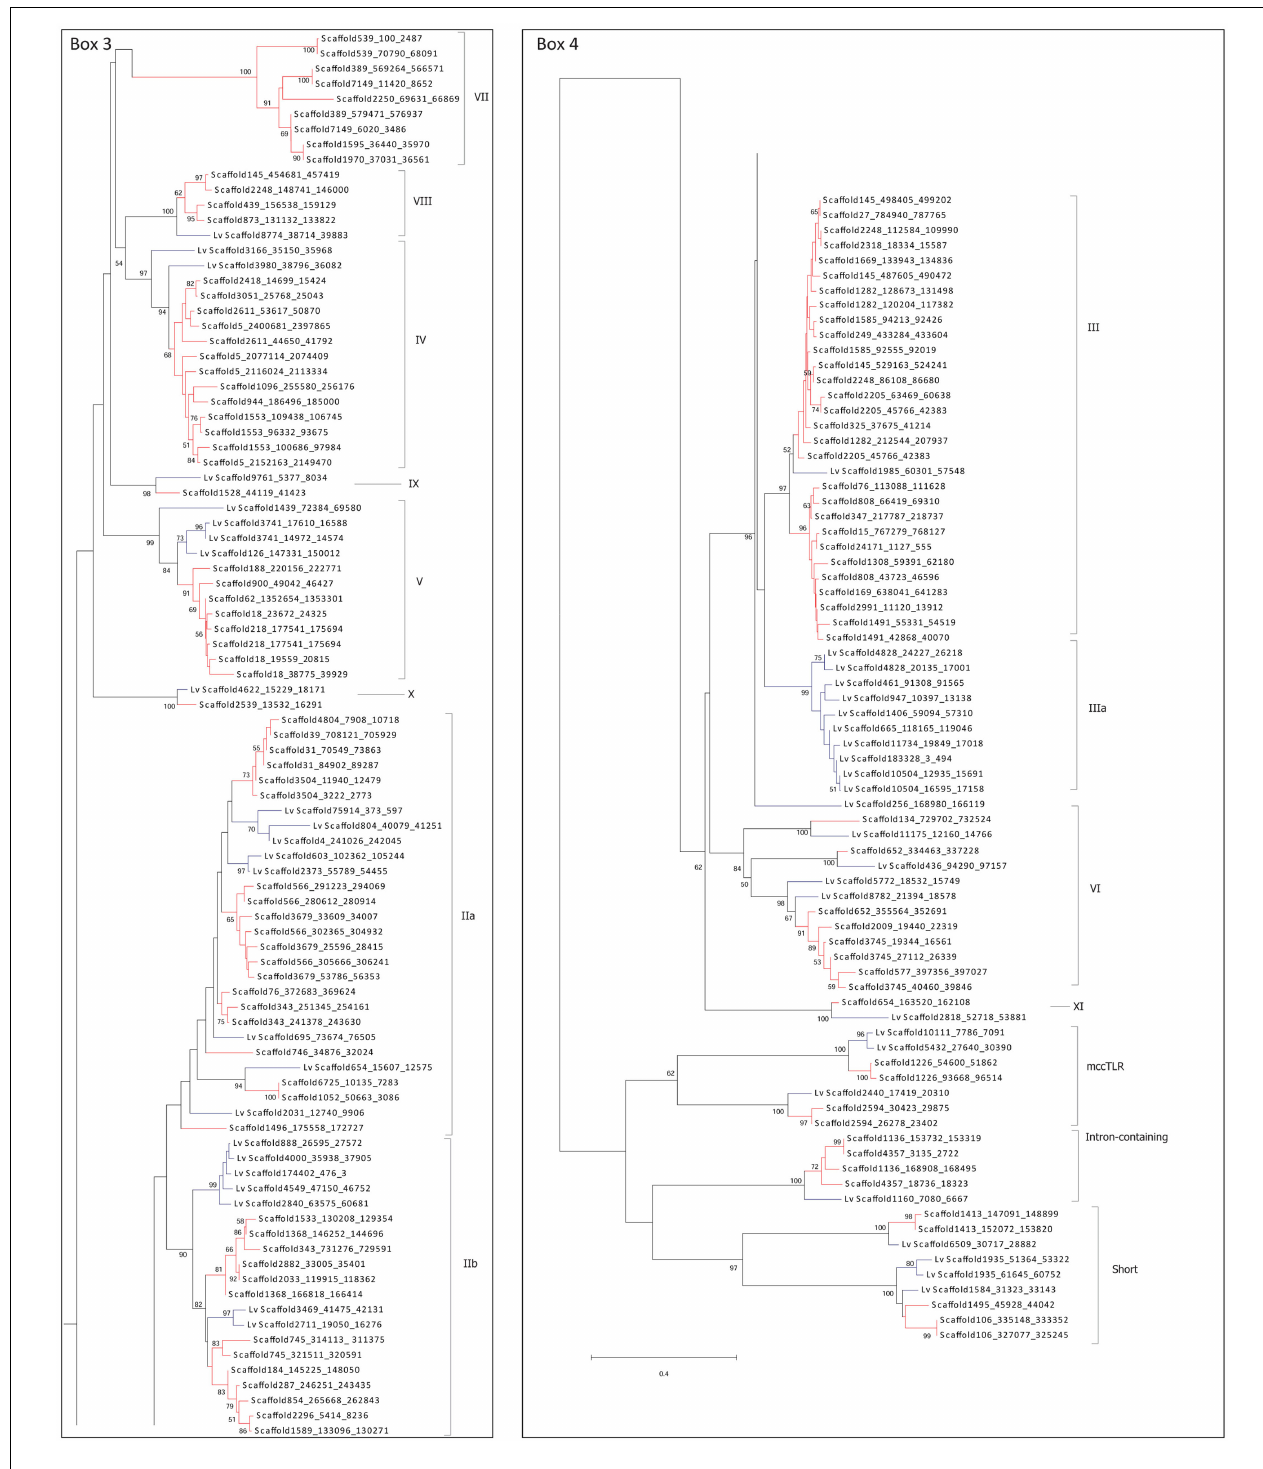
the boxes (1–4) is shown in greater detail as indicated.The sequences are labeled by scaffold number and the position of the open reading frame (scaffold_start_stop). More information about the sequences can be found in Tables S1 and S2 in Supplementary Material. Subfamily designations are indicated on the right of each tree and correspond to those shown in Figure 2